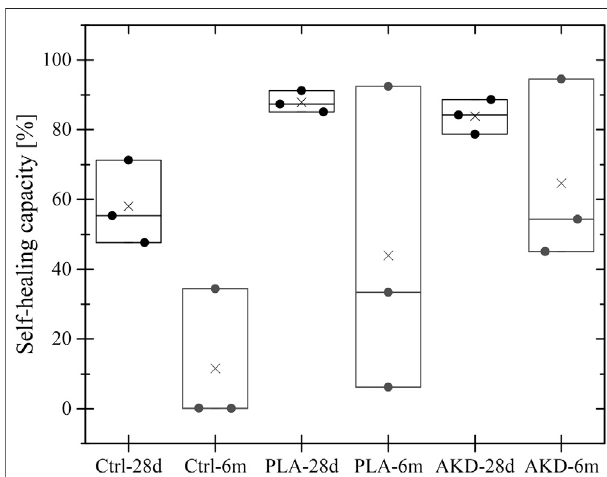
FIGURE5| Boxplotaboutwaterpermeabilitytestofspecimenscracked at 28 days (X-28d) and 6 months (X-6m). Individual measurements are showed by dots, while the average value for each series is shown by crosses. The middle bar is representative for the median value, while the top and bottom bars are representative for the maximum and minimum value of each series,